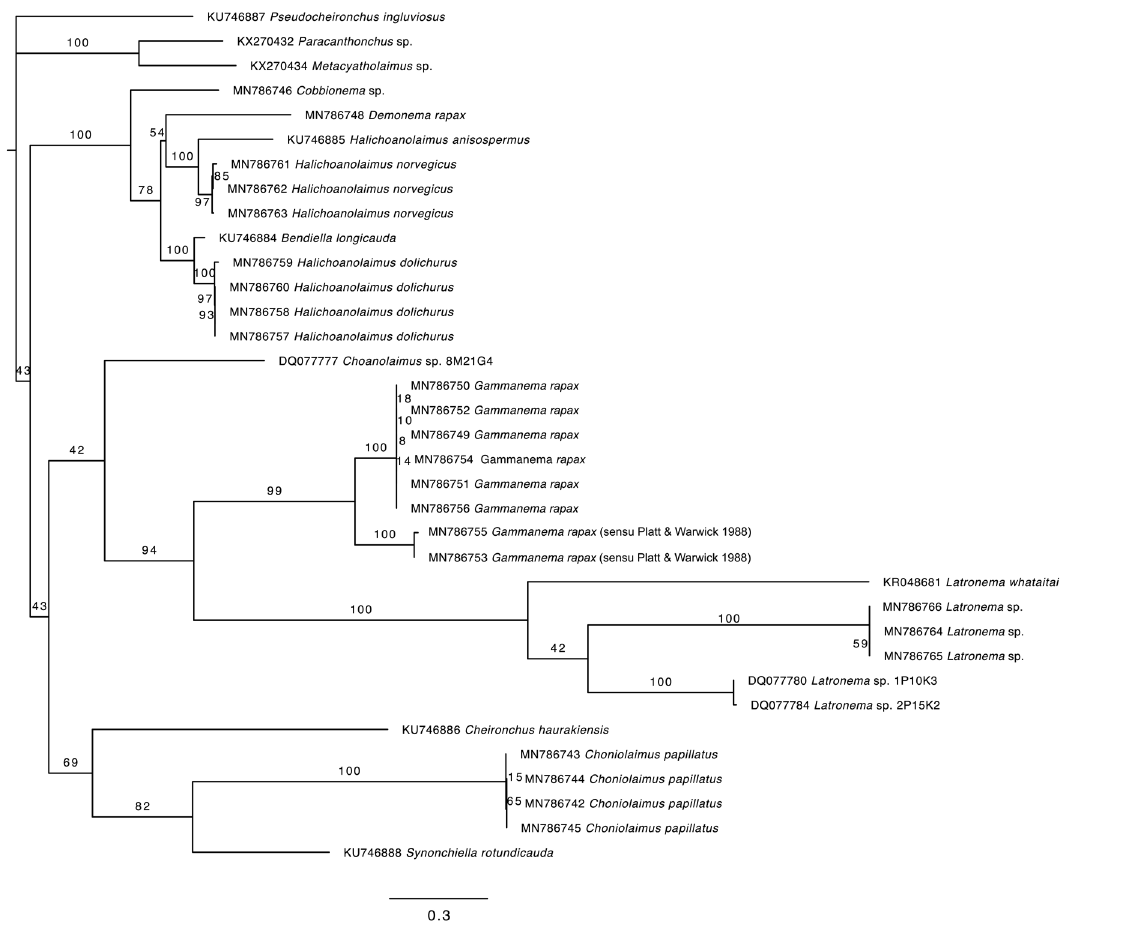
Fig. 12. Maximum Likelihood phylogenetic tree of Selachinematidae Cobb, 1915 inferred from 28S rRNA data, using alignments based on secondary structure models using GTR GAMMA for unpaired sites and RNA7A for paired